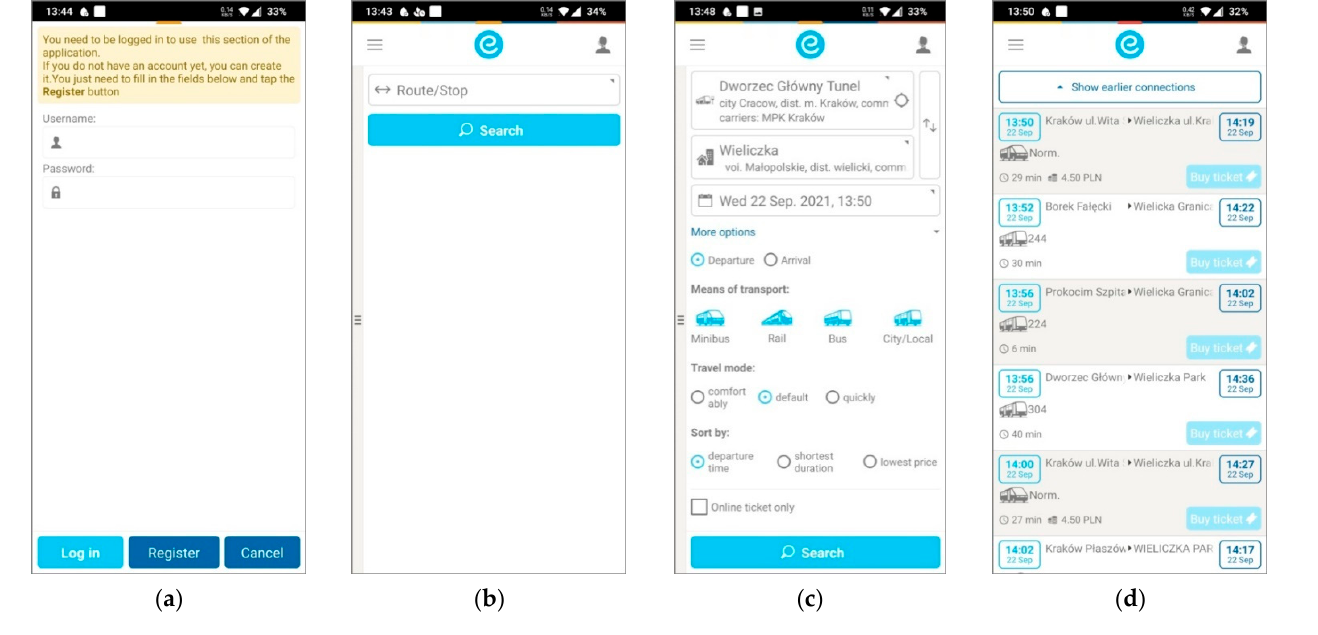
Figure 1. Summary of selected tabs of the E-podróznik.pl application: ( a ) logging in a new user; ( b ) searching for routes and stops; ( c ) defining detailed travel options; ( d ) information on possible connections between the defined points.